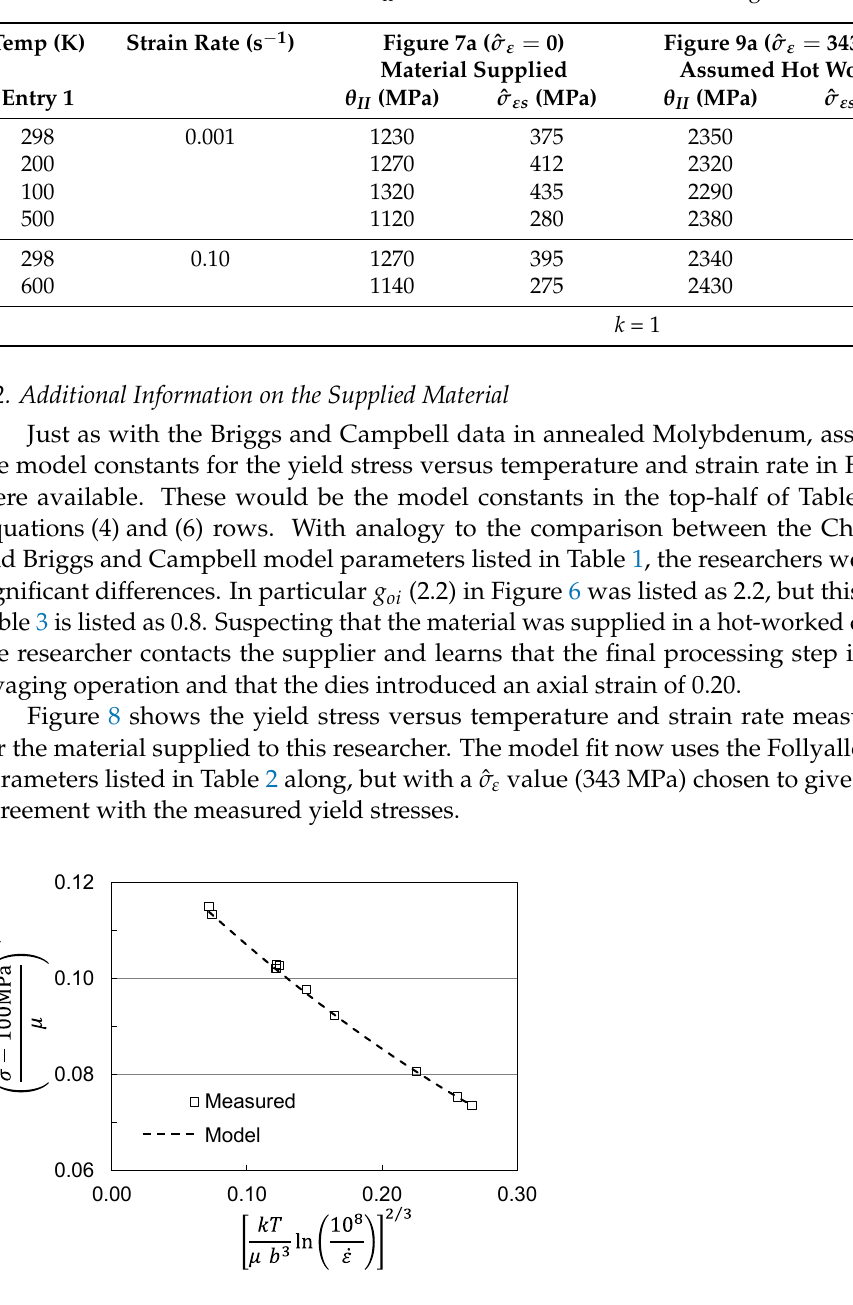
Figure 8. Yield stress versus temperature and strain rate in hot worked Follyalloy.